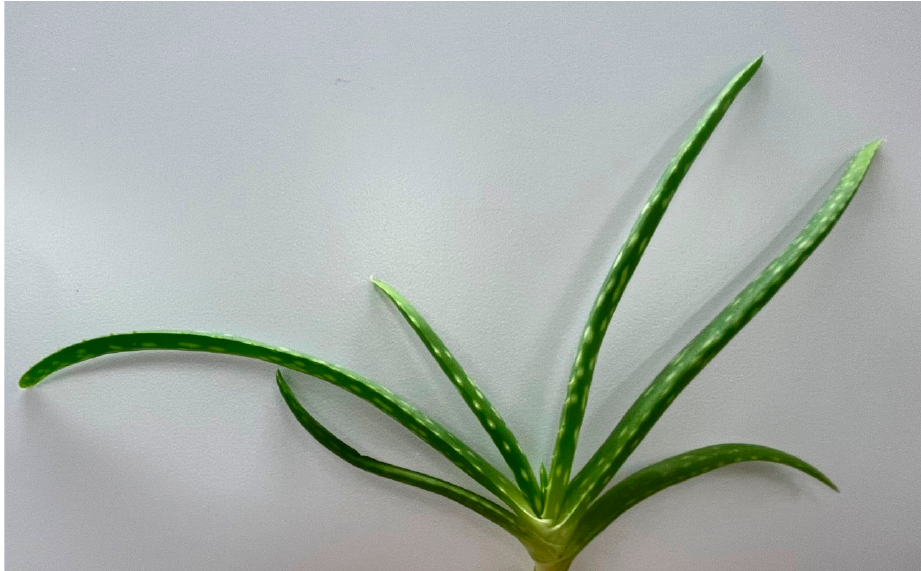
Figure 10. Photo of Aloe vera (L.) Burm.f. (copyright held by Royal Botanical Gardens, Kew).